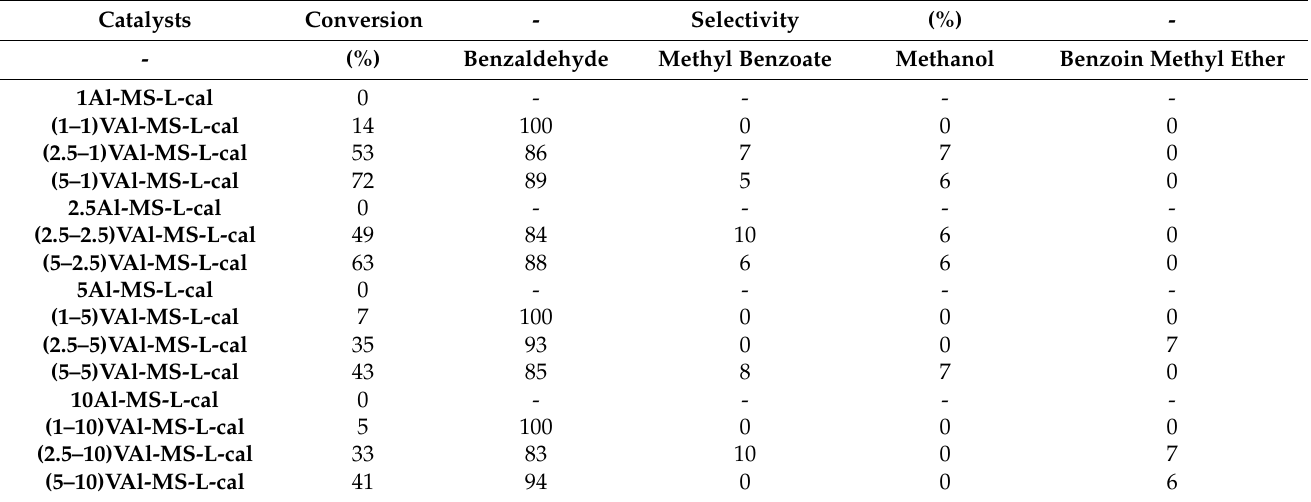
Table 2. High-throughput screening of 1,2-diphenyl-2-methoxyethanol oxidation using Al anchors. Catalysts Conversion -